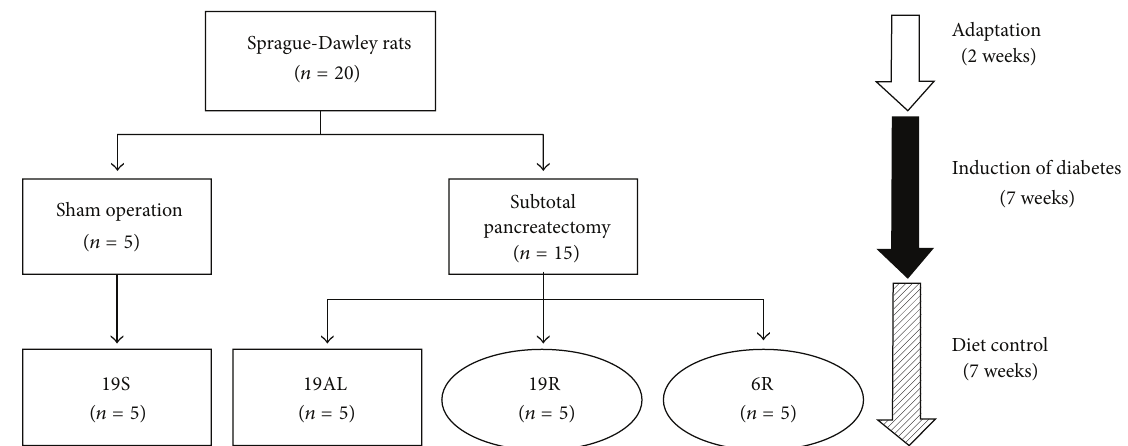
Figure 1: Animal study design. Square boxes: ad libitum diet; ovals: calorie-controlled diet; 19S: sham-operated rats fed standard chow ad libitum (protein 19.4, carbohydrate 68.8, and lipid 11.8kcal%); 19AL: pancreatectomized diabetic rats fed standard chow ad libitum ; 19R: pancreatectomized diabetic rats fed calorie-controlled standard chow to achieve euglycemia during the diet control period; 6R: pancreatectomized diabetic rats fed a calorie-controlled low protein diet (protein 6.0, carbohydrate 82.2, and lipid 11.8kcal%) to achieve euglycemia during the diet control